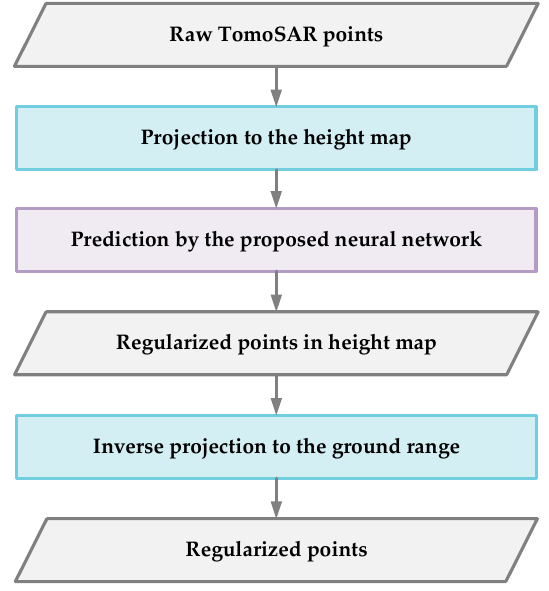
Figure 1. The processing flow of our regularization method for the TomoSAR point clouds.